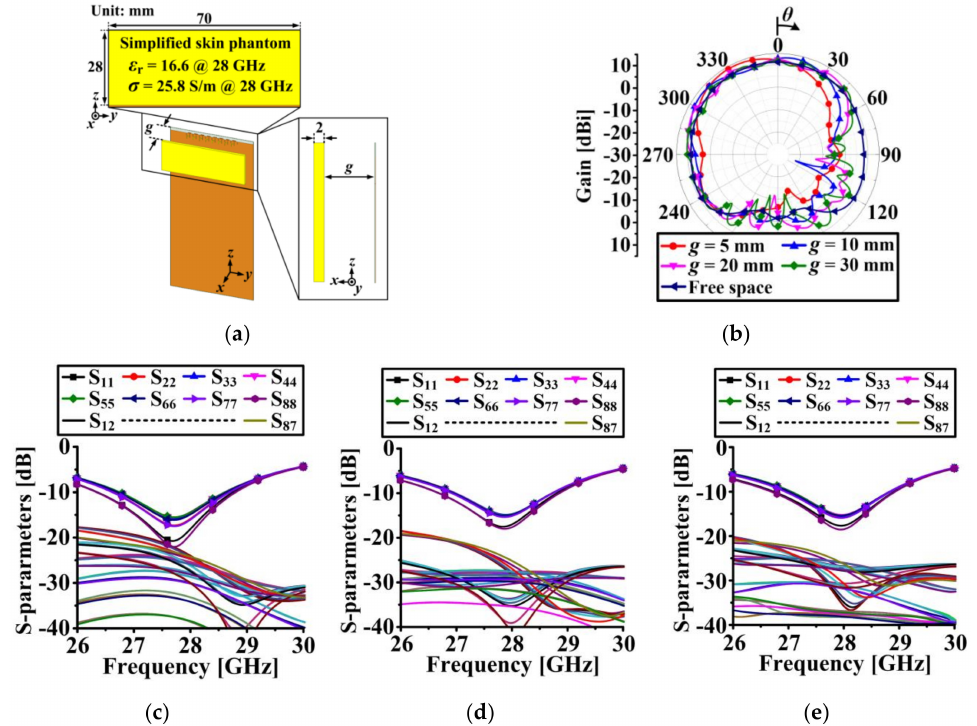
Figure 15. The 1 × 8 array antenna with a simplified skin phantom: ( a ) simulation setup, ( b ) simulated radiation patterns in the xz plane for various g values at 28 GHz, ( c ) simulated S-parameters when g = 5 mm, ( d ) simulated S-parameters when g = 10 mm, and ( e ) simulated S-parameters when g = 20